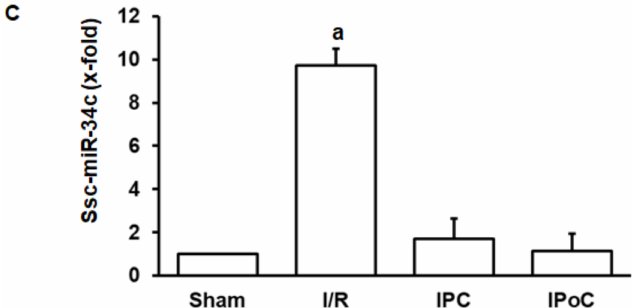
Figure 5. Expression of swiprosin-1, MCP-1, and ssc-miR-34c in the border zone (BZ) or infarct zone (IZ) three hours or 3 days after reperfusion. The quantification for ssc-miR-34c was performed in the infarct zone 3 h after